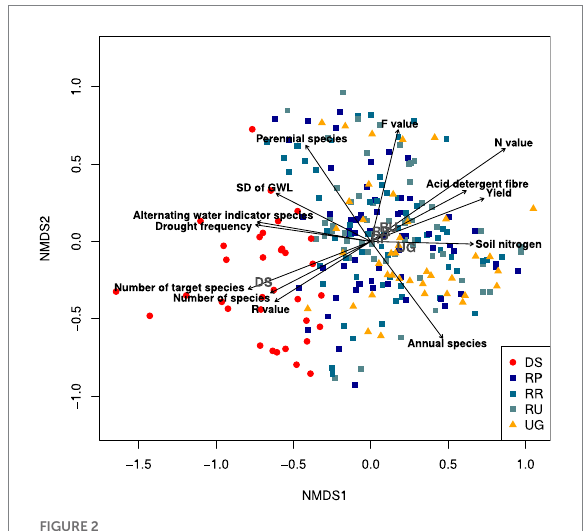
FIGURE 2 Non-metric multidimensional scaling (NMDS) of the vegetation plots for all restoration sites, the unrestored reference grassland and the donor sites in 2021 (axis 1 and 2 of the three-dimensional solution are shown). Final stress: 16.9. Plots are grouped by donor sites (DS), unrestored reference grassland (UG), and restoration sites with the treatments ploughed (RP), rotovated (RR), and untilled (RU). The group labels are located at the centroids of the groups. Vectors with r 2 > 0.3 are displayed. For better readability, the cover of target species, the metabolisable energy (high correlation with number of species and target species) were removed despite r 2 >